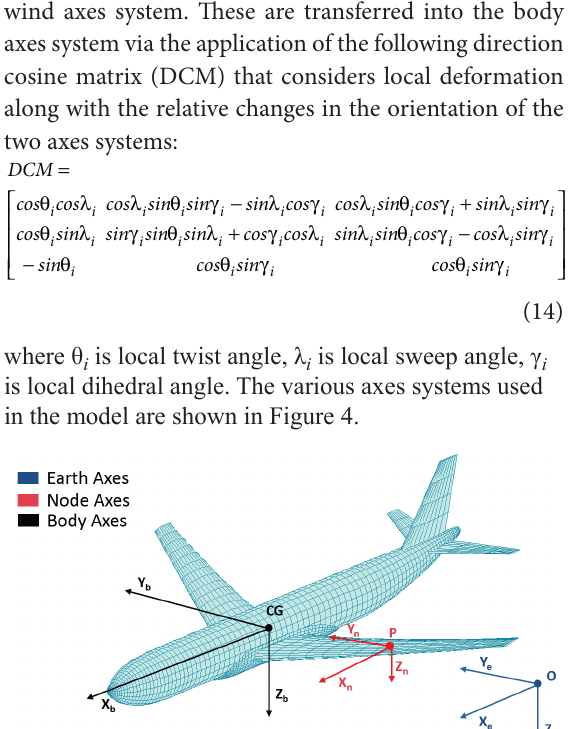
Fig. 4. Different axes systems used in the model